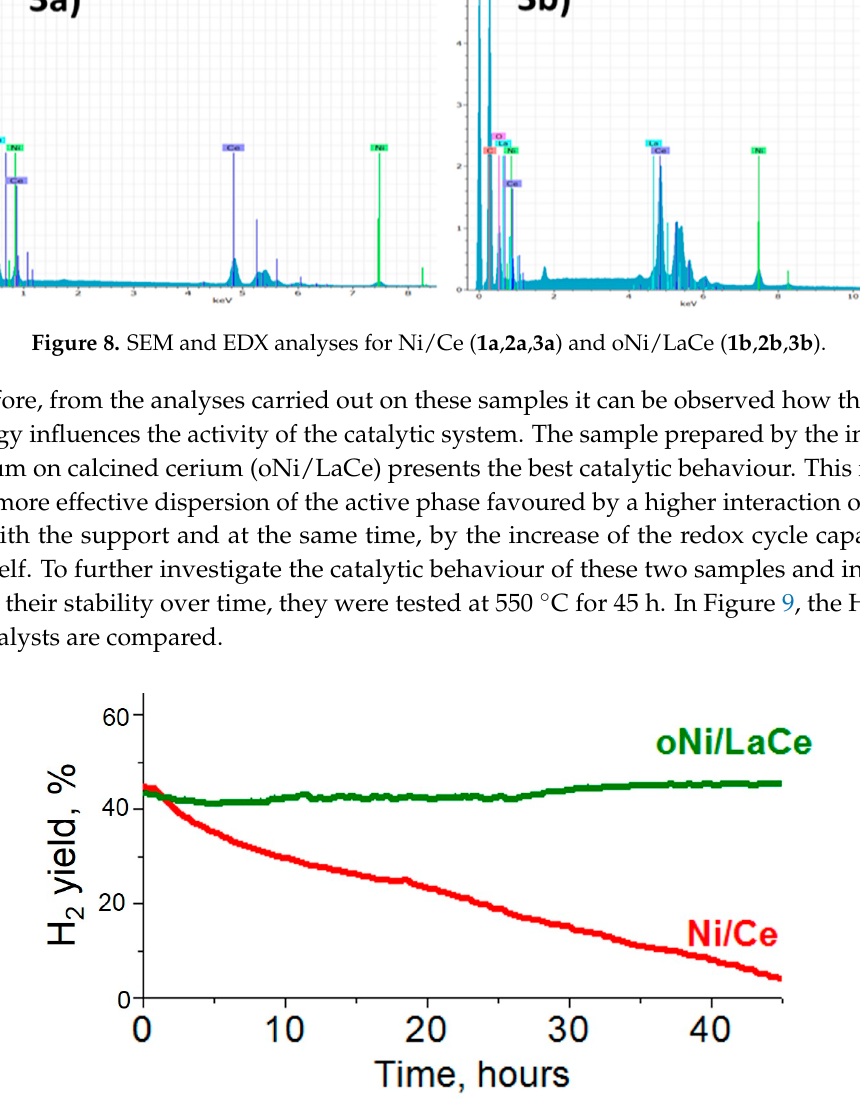
◦ C for Ni/Ce and oNi/LaCe Figure 9. H 2 yield for reaction at 550 °C for Ni/Ce and oNi/LaCe samples. Figure 9. H 2 yield for reaction at 550 Figure 9. H 2 yield for reaction at 550 °C for Ni/Ce and oNi/LaCe samples.